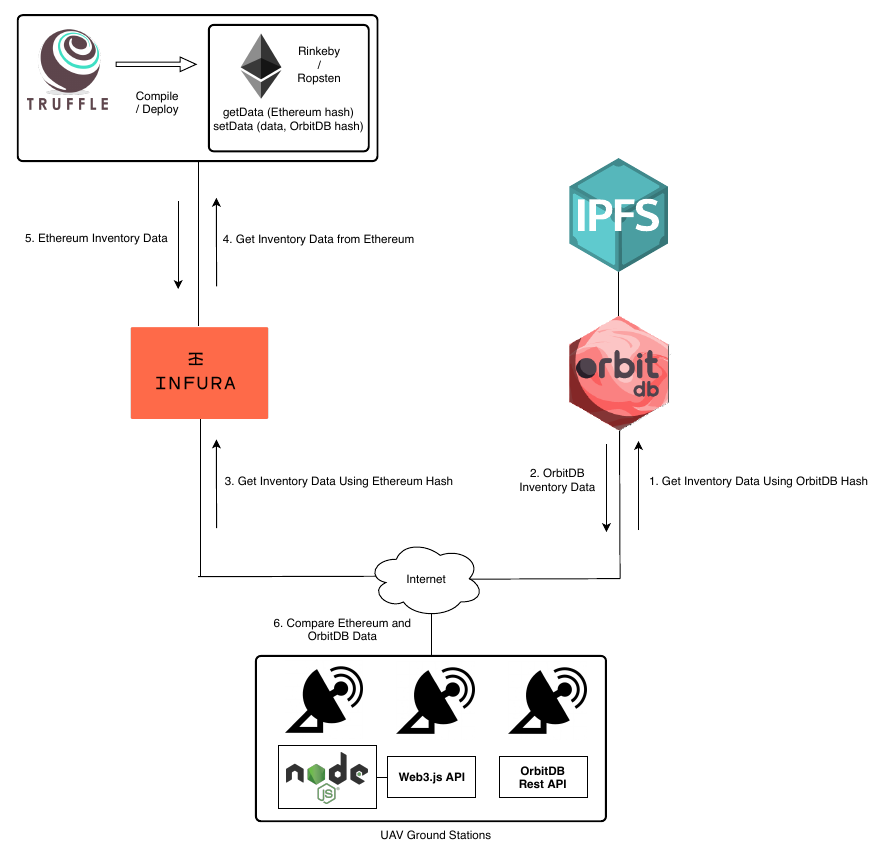
Figure 6. Inventory data verification